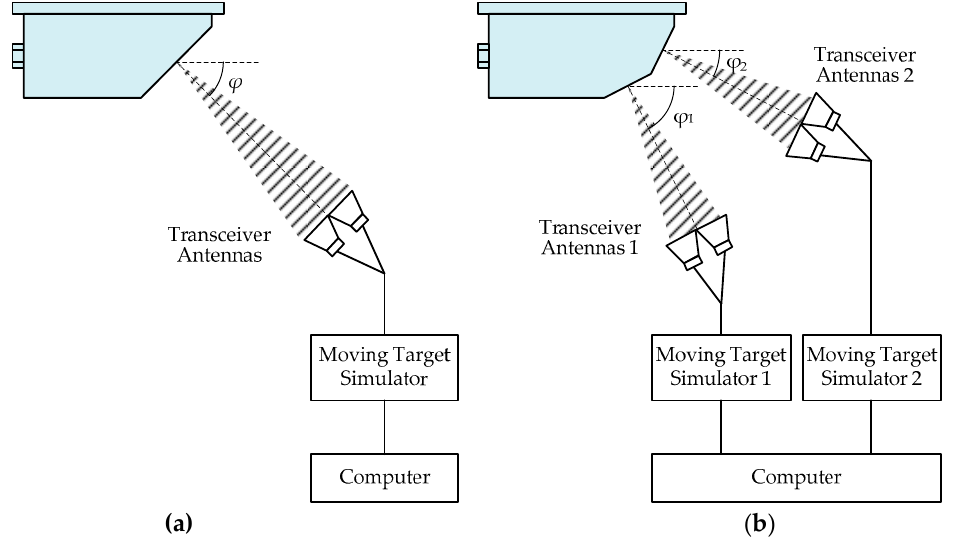
Figure 8. Schematic diagram of the proposed speed calibration method: ( a ) For the train-borne single-channel DRS; ( b ) For the train-borne dual-channel DRS.